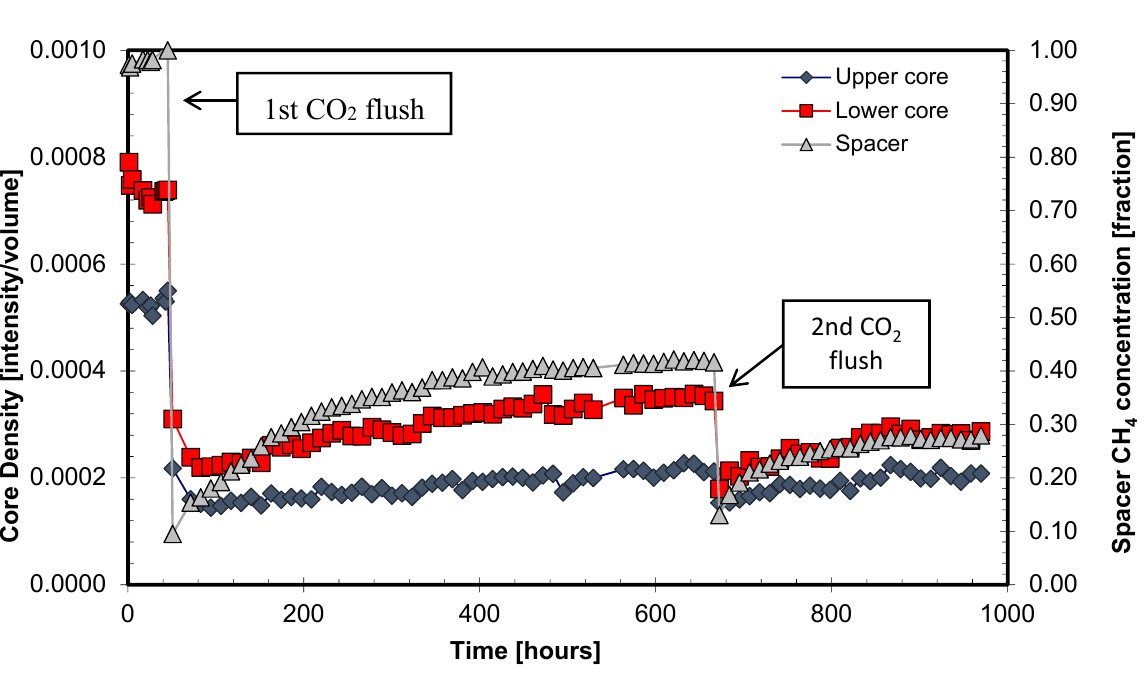
Figure 6. Comparison of intensity progression in the two core halves and spacer volume during CO 2 injection and exchange. The hydrogen density is efficiently reduced as CO 2 diffuses into the core segments. The slight monotonically increasing trend suggests release of CH 4 as a result of exchange. Each image was acquired over 2 h and 17